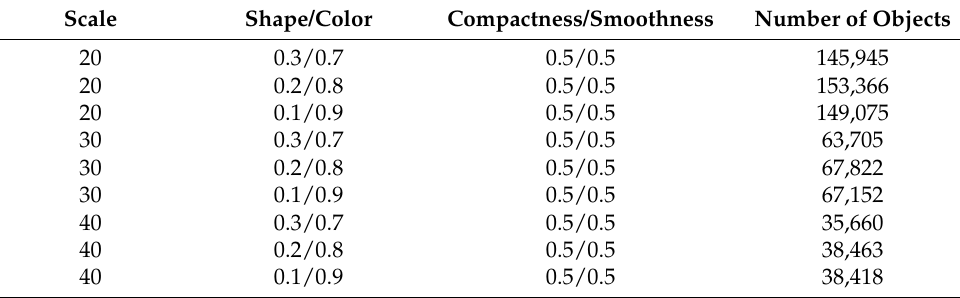
Image layers used: red band, green band, and blue band (weighted